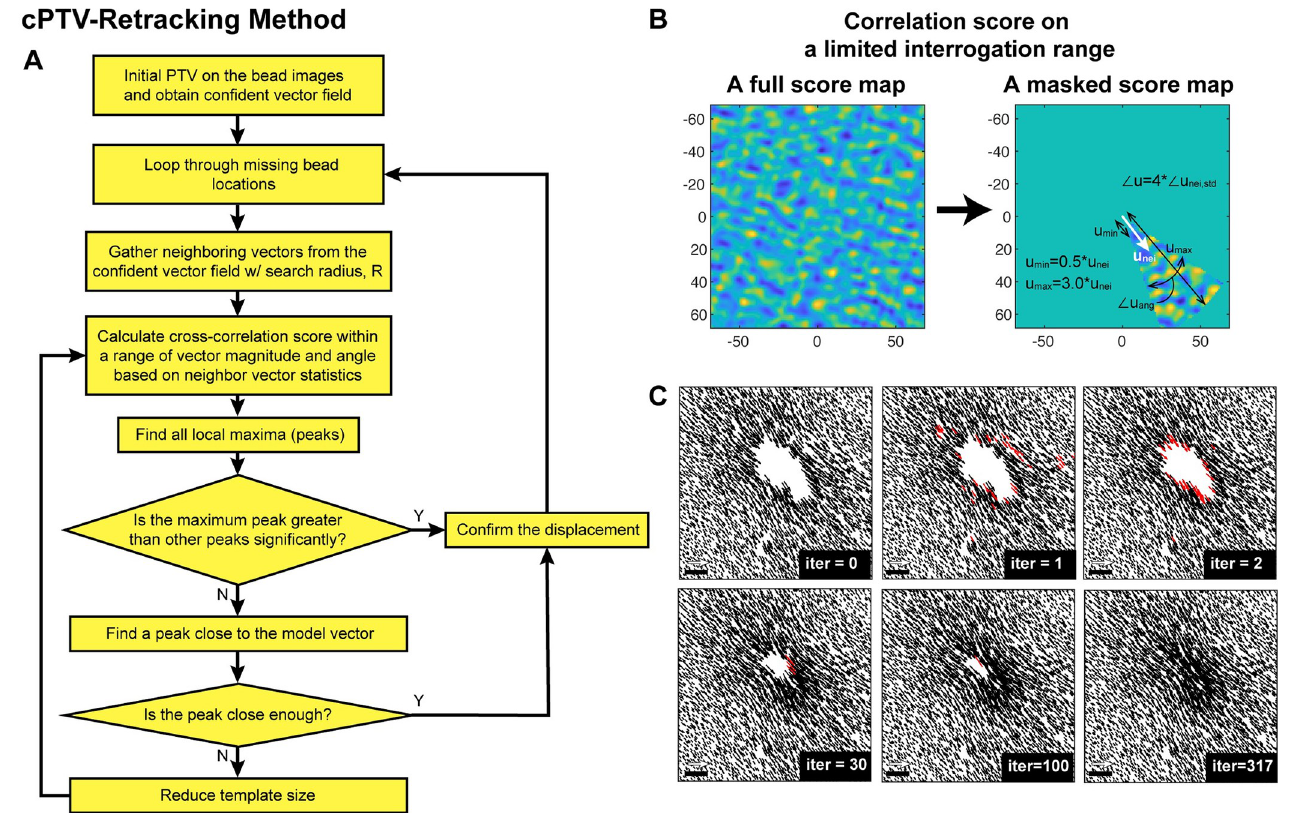
Fig 3. cPTV-Retracking algorithm. (A) Flowchart of the main algorithm of cPTV-based retracking. See the main text or Methods section for detailed description of this chart. (B) An example of a masked correlation score map (right) compared to a full score map (left), which is used in step 4 of the flowchart. A white arrow on the masked score map, u nei , is the averaged neighboring vector. The range of the radius of the mask was determined as 0.5 � |u nei | � |u| � 3 � | u nei |, and the range of the angle was deteremined as mean(u nei )-2 � std(u nei ) � u � mean(u nei )+2 � std(u nei ) where the symbol, , represents the orientation of each vector. (C) A series of displacement vector fields at representative iterations, showing how progressively missing vectors are found. Red vectors represent the newly-found vectors at the specific iteration. At zeroth iteration, the field is filtered by a vector median filter with a strict threshold so that the retracking is performed based on the confident neighboring vectors. The last field at iteration = 317 is the result from the last iteration, i.e., when there was no single retracked vector for 30 consecutive